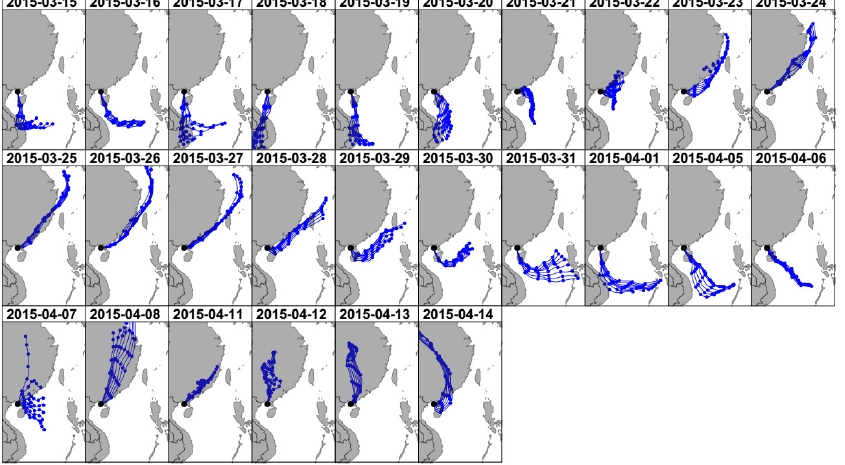
Figure 4. 72-h HYSPLIT back trajectories centered Weizhou Island from 15th March to 14th April for each day.